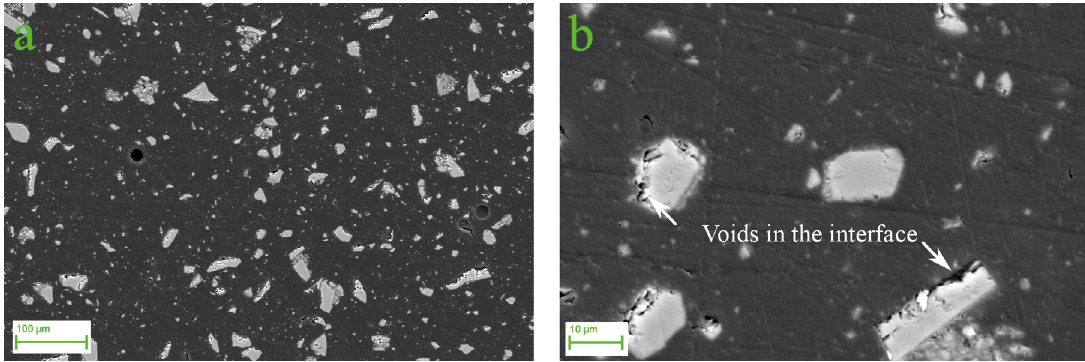
Figure 11. SEM microphotograph of a sample containing 20% (wt) fused silica Bars: A - 100 µm; B - 10 µm